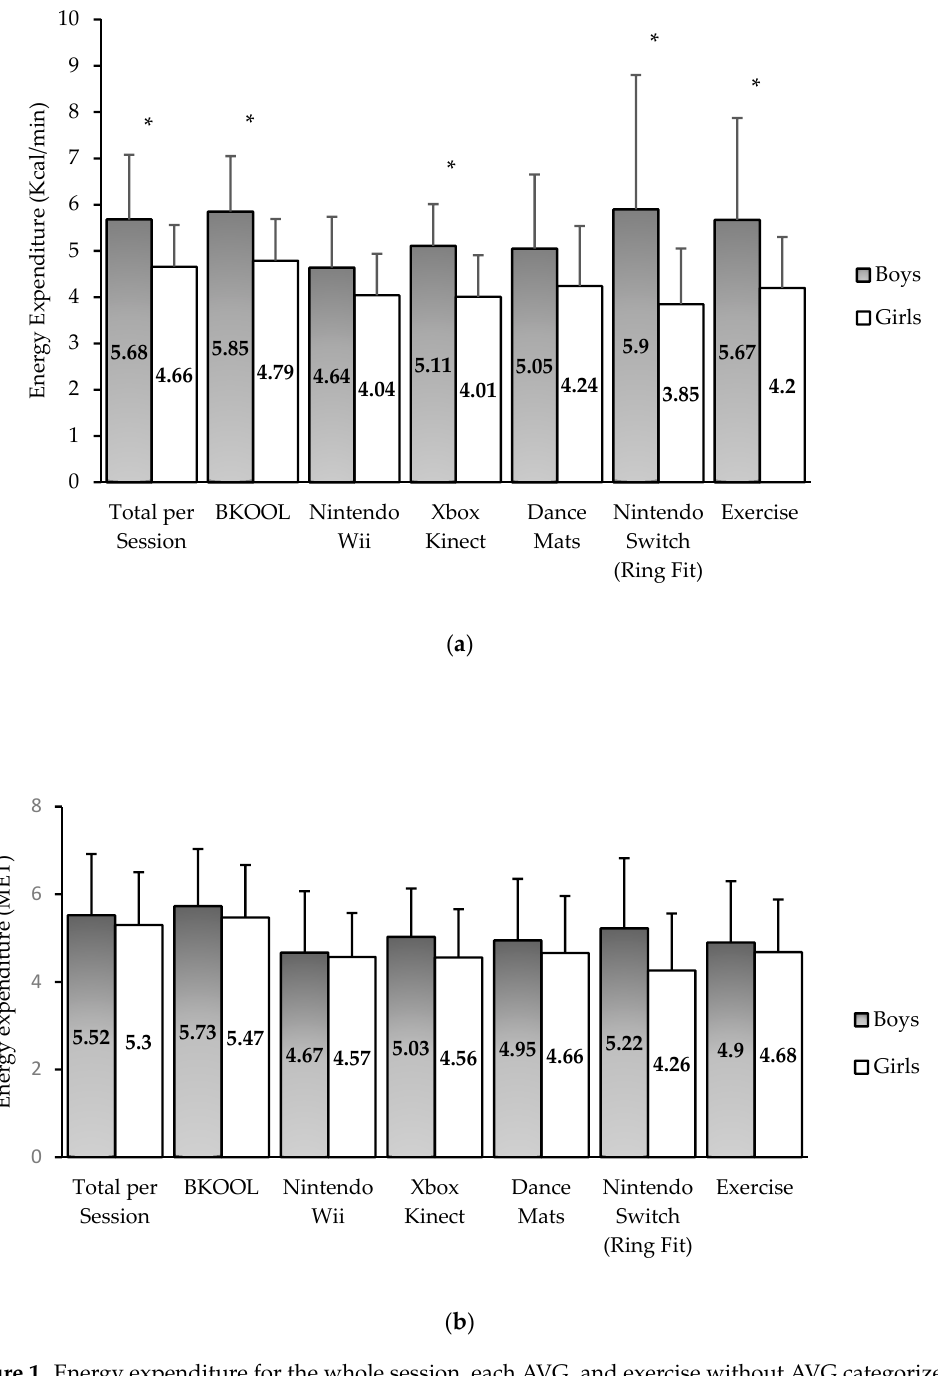
Figure 1. Energy expenditure for the whole session, each AVG, and exercise without AVG categorized by gender. * Indicates a statistically significant difference between boys and girls ( p < 0.05). ( a ) Energy expenditure measured in kcal/min; ( b ) Energy expenditure measured in MET.